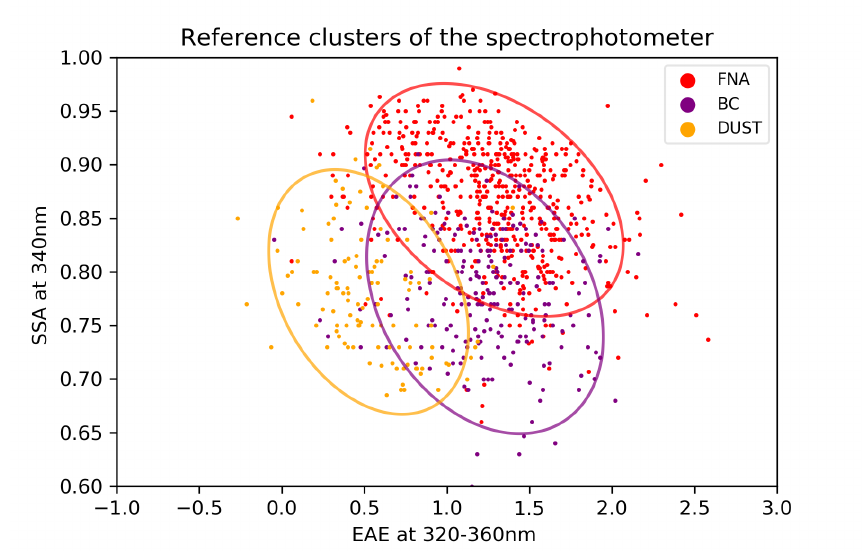
Figure 3. The training dataset of Brewer cases is presented in this figure. The 90% cumulative probability contour is used for the visualization of the cluster ellipses. It occurs at a Mahalanobis distance of